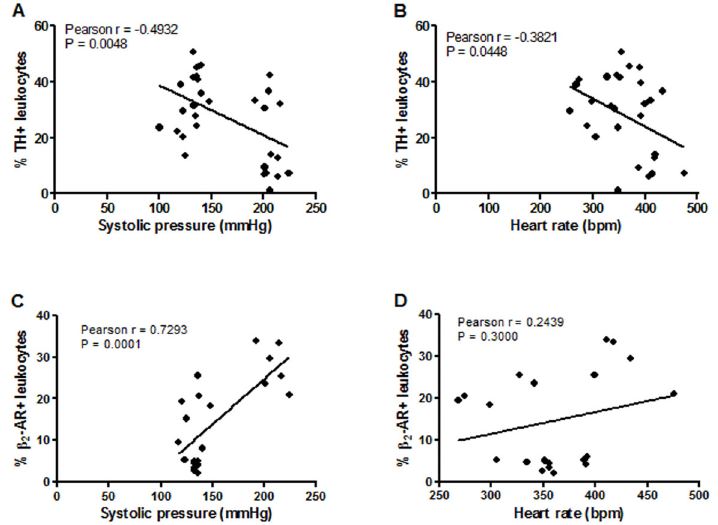
Figure 4. Pearson ’ s correlation of the percentage of leukocytes positive for tyrosine hydroxylase (TH) ( A and B ) or b 2 -adrenergic receptor ( b 2 -AR) ( C and D ) with heart rate and systolic blood